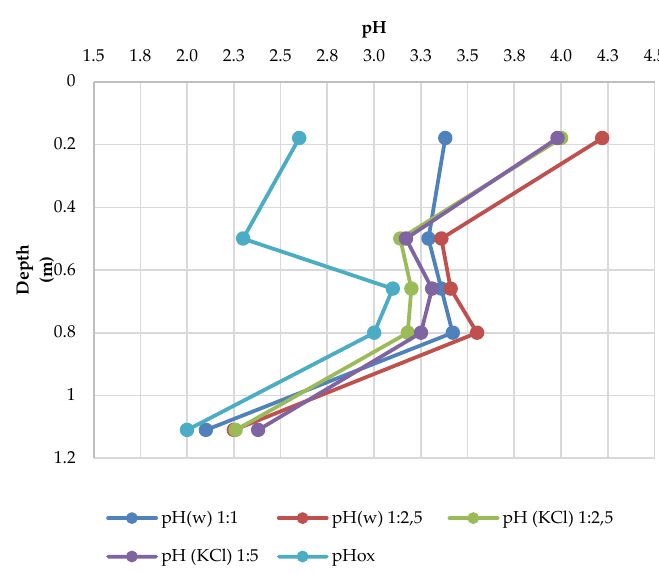
ff erent types of pH obtained for profile Figure 3. Variation in depth of the different types of pH obtained for profile 1. 244 Figure 3. Variation in depth of the di